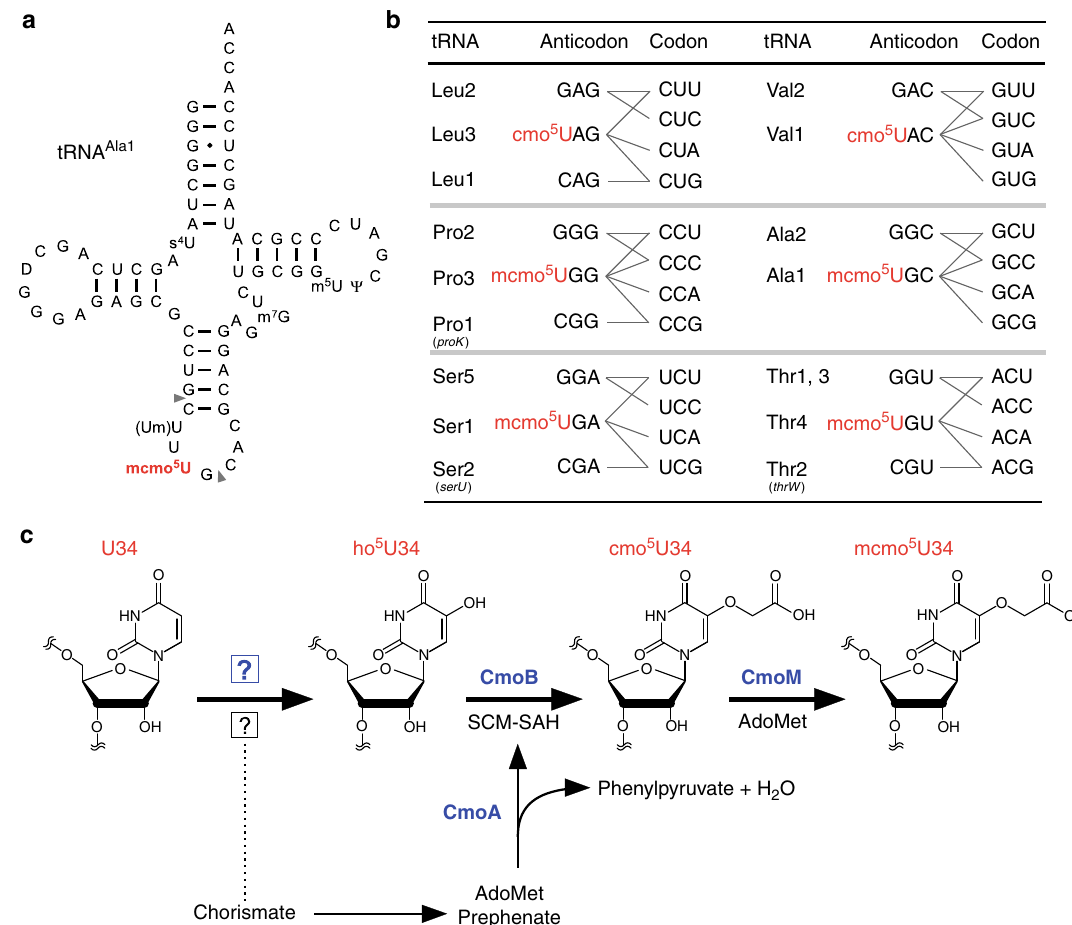
proteins: rlhA , yegQ , yhbU , and yhbV (Supplementary Fig. 1, respective knockout strains, digested with RNase T 1 , and sub- jected the digests to capillary LC-nano-ESI-mass spectrometry (RNA-MS) to detect tRNA fragments containing cmo 5 U